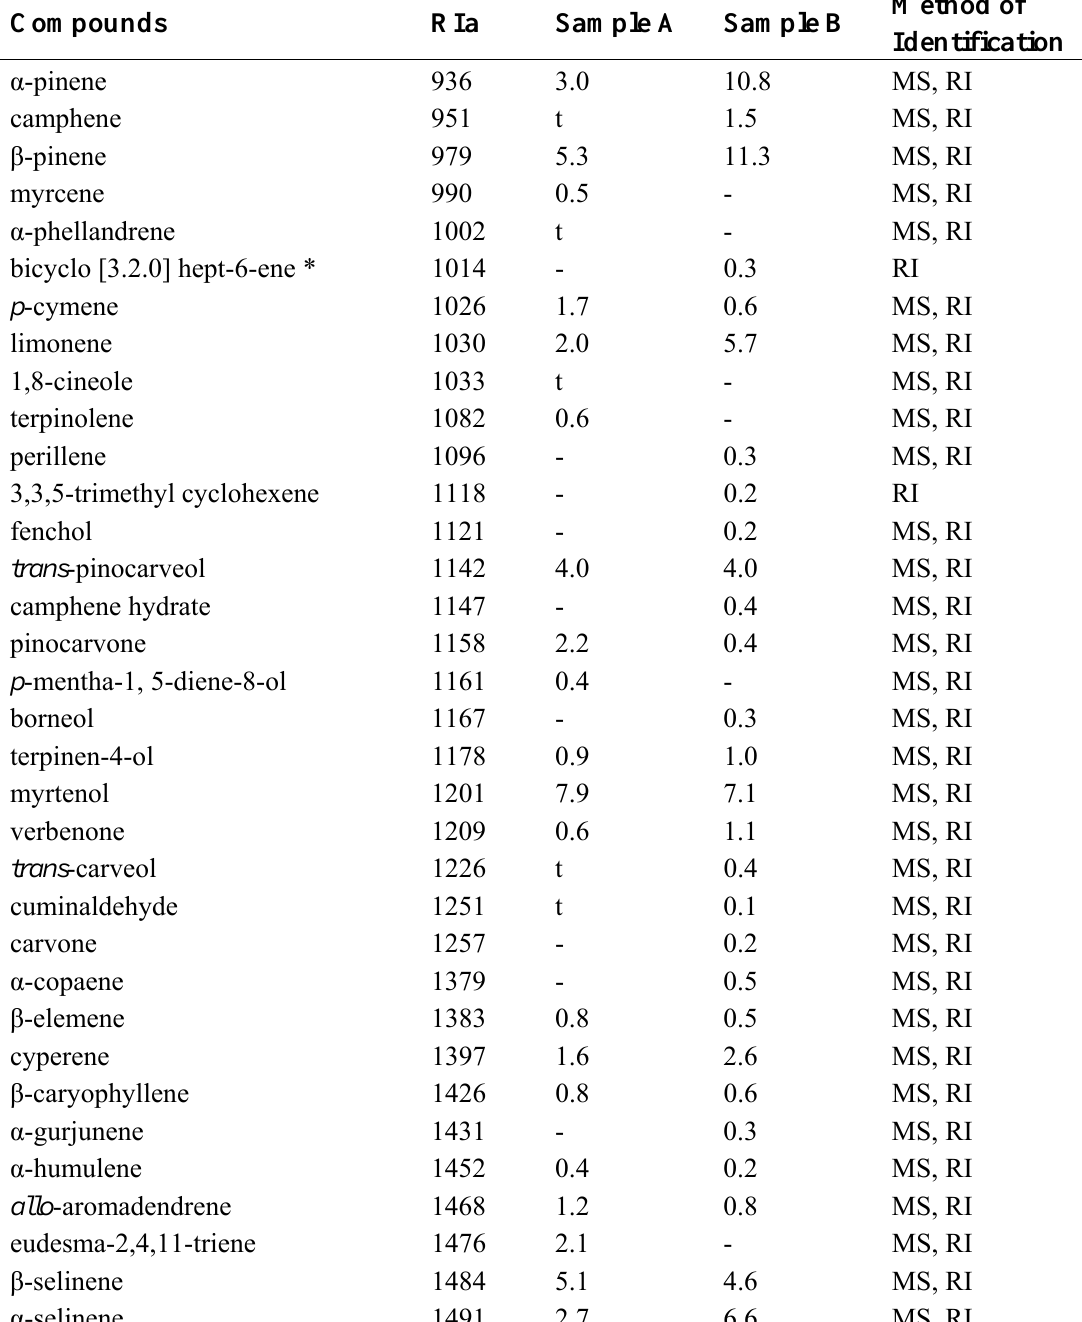
Table 1. Percentage composition of C. rotundus essential oils from two different locations. Compounds RIa Sample A Sample B